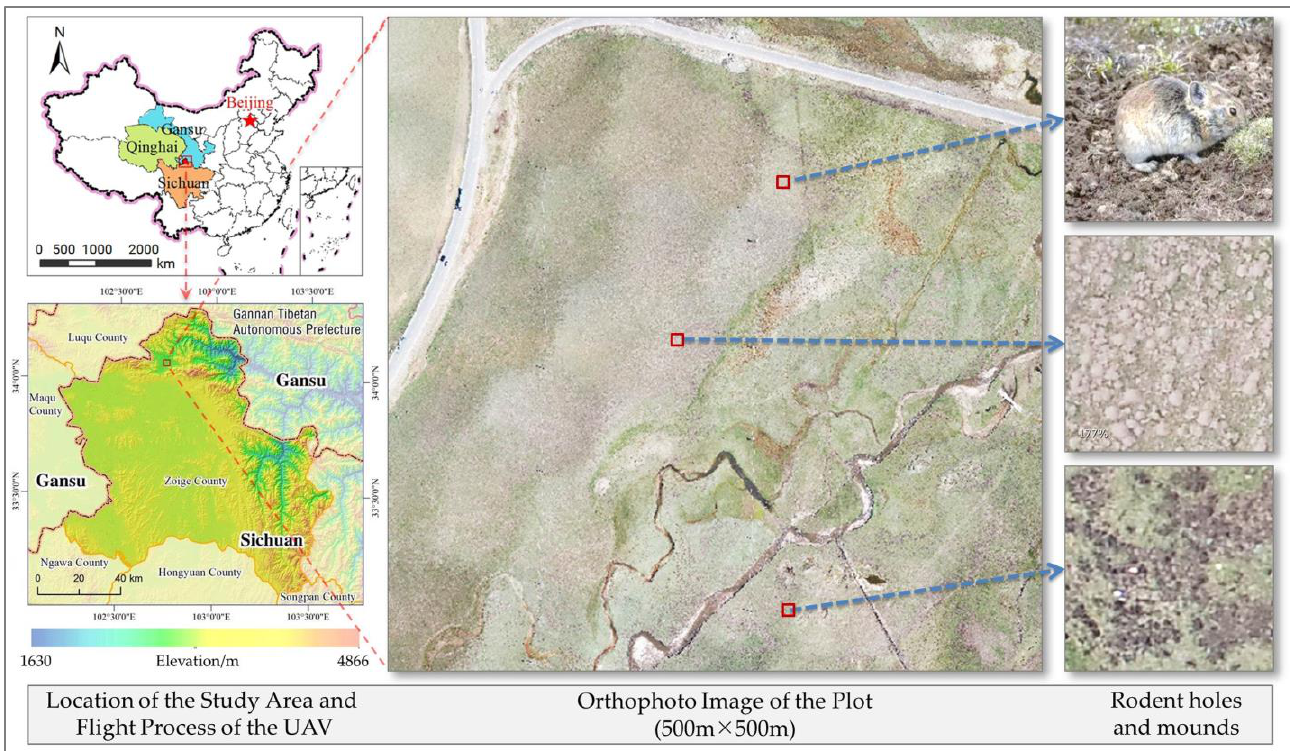
Figure 2. Location of the study area.